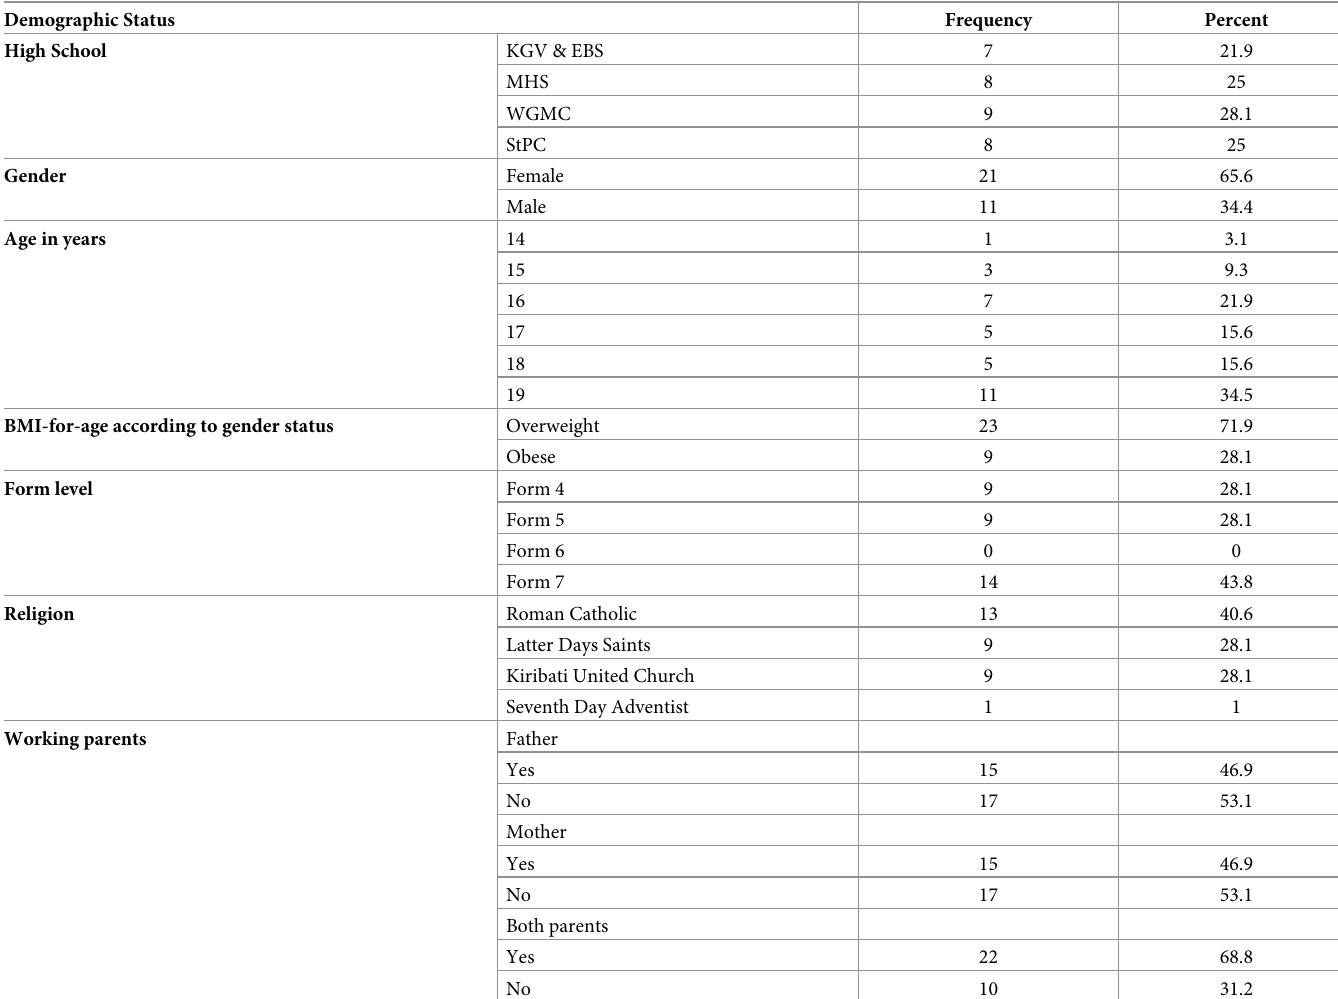
Table 1. General characteristics of students (n =